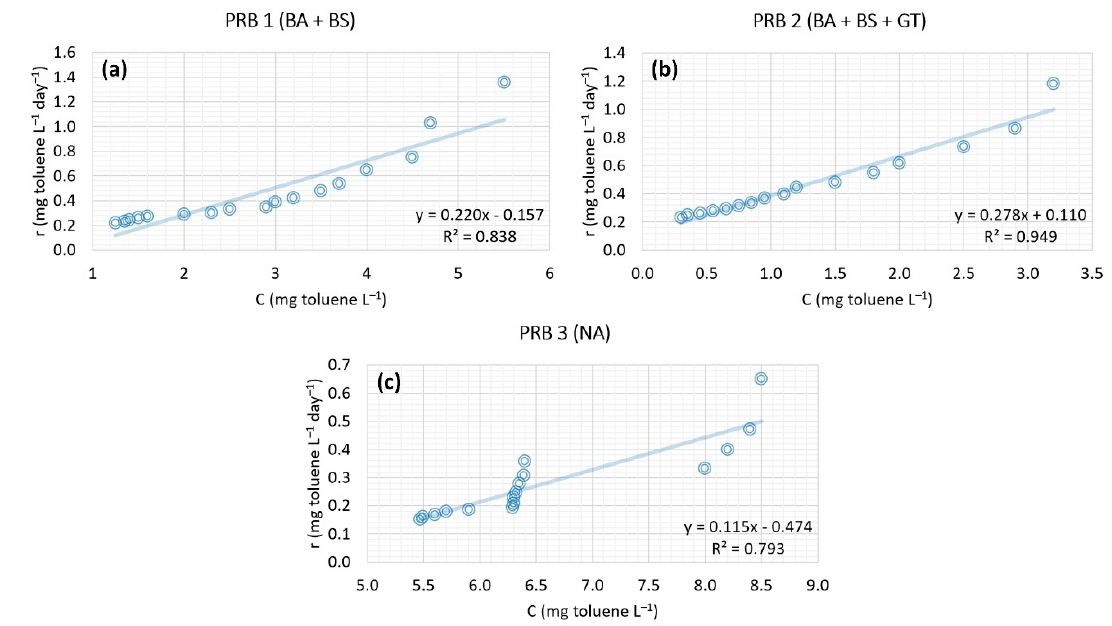
Figure 9. Reaction rate data for the PRB toluene treatment processes for phase 1: ( a ) The first-order model for PRB-1, ( b ) the first-order model for PRB-2, and ( c ) the first-order model for PRB-3.